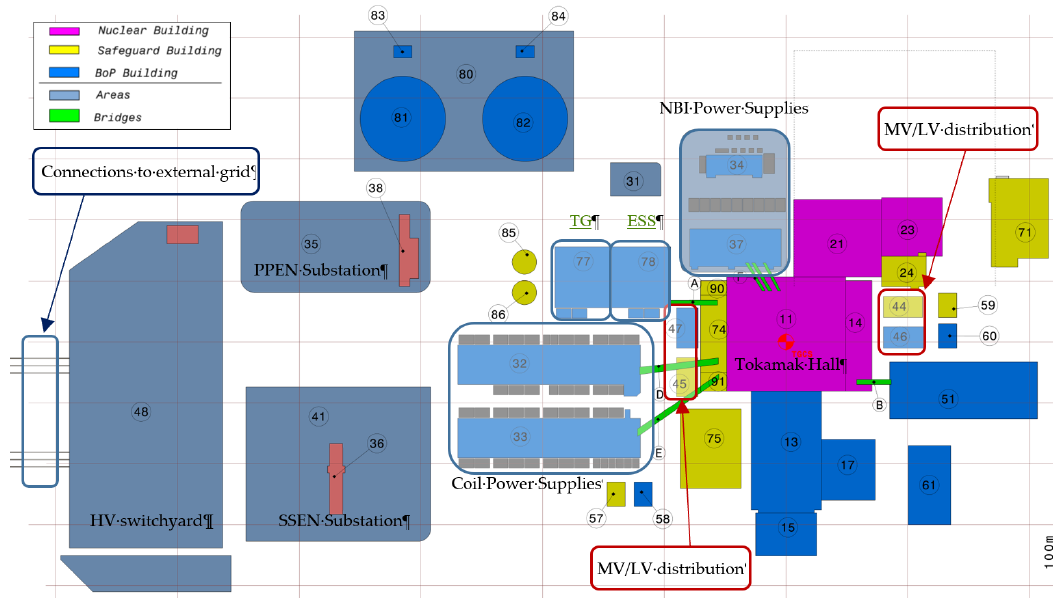
Figure 3. Preliminary layout of the EU-DEMO site.